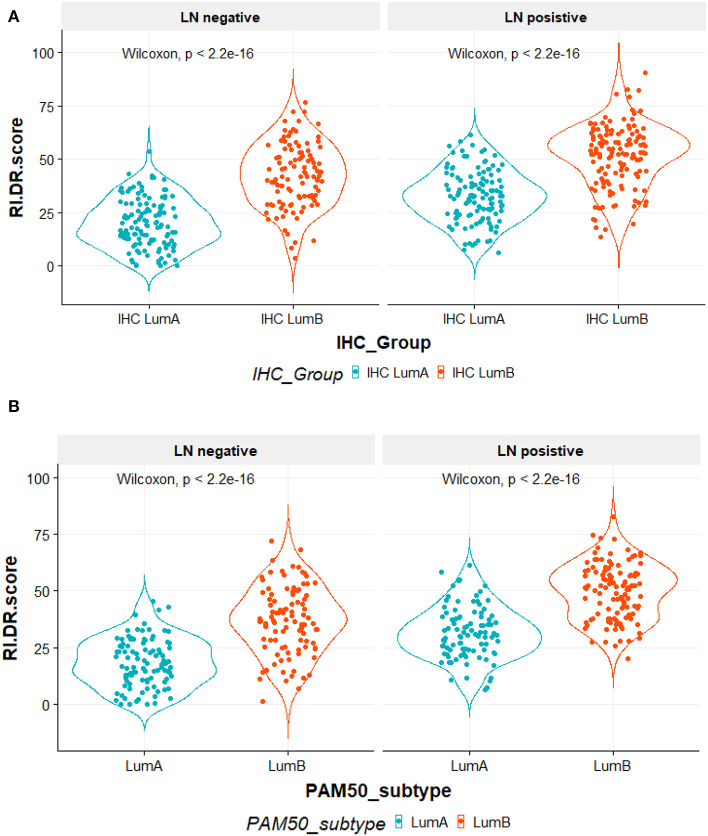
(A) All 490 patients were classified according to immunohistochemical (IHC) studies by ER, PR, and HER2 receptors. IHC LumA subtype was defined as patients with ER/PR positive, HER2 negative and grade 1–2 tumors. IHC LumB subtype was defined as patients with ER/PR positive, HER2 negative, and grade 3 tumors. The X-axis is the IHC subtypes, the Y-axis is the RI-DR (recurrence index for distant recurrence) scores. The RI-DR scores in IHC LumA subtype were lower than the scores of IHC LumB. This observation was consistent in both node-negative and -positive patients (Wilcoxon p < 2 2e-16). (B) All 404 patients were identified by research-based PAM50 intrinsic subtypes using R genefu package. Luminal subtypes (LumA and LumB) were classified accordingly. The X-axis is PAM50 subtypes, the Y-axis is RI-DR (recurrence index for distant recurrence) scores. The RI-DR scores of Luminal A were lower than the scores of Luminal B. This observation is consistent in both node-negative and -positive patients (Wilcoxon p < 2 2e-16).